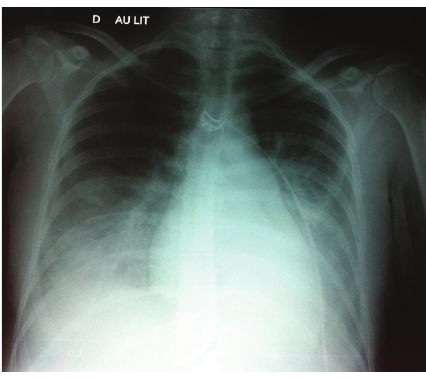
Figure 1: Chest X-ray face-on in prone position (Case